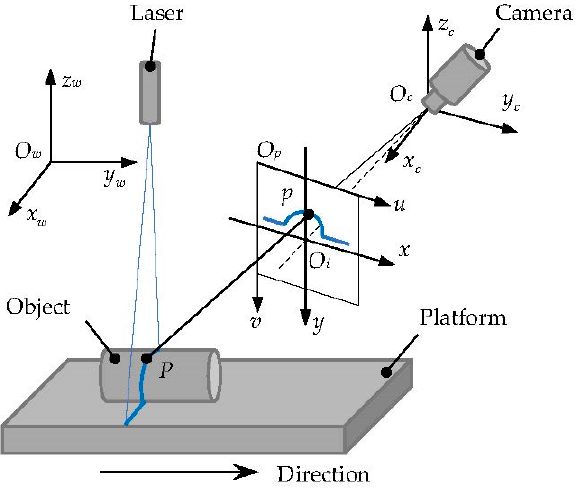
Figure 2. Point cloud acquisition system model.